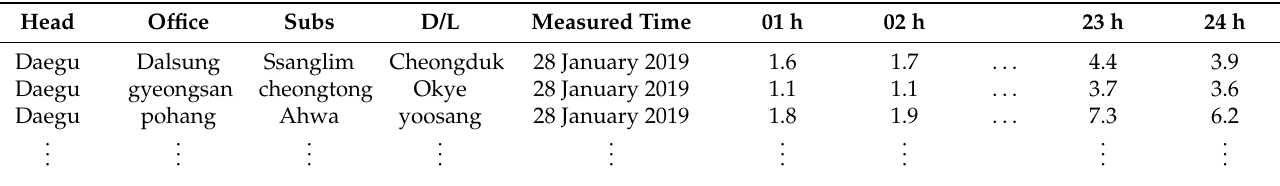
Figure 2. Flowchart of preprocessing for short-term load transfers and abnormal data. Table 2. Example of the DLs load data from SOMAS.